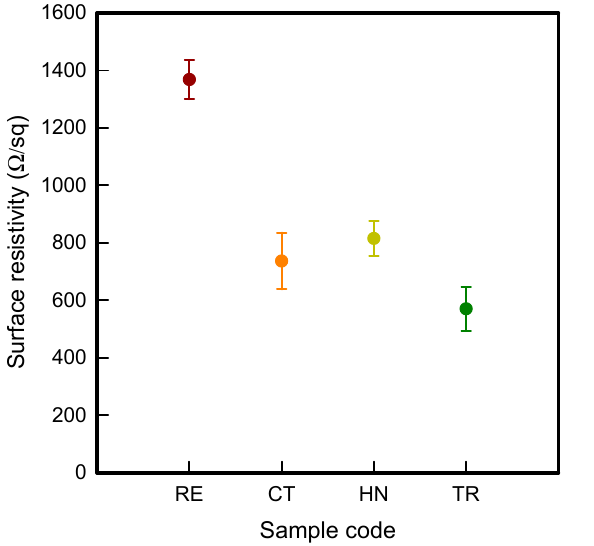
Figure 1. Surface resistivity of 4 types of CFDM 3D printed graphene/PLA auxetic patterns.